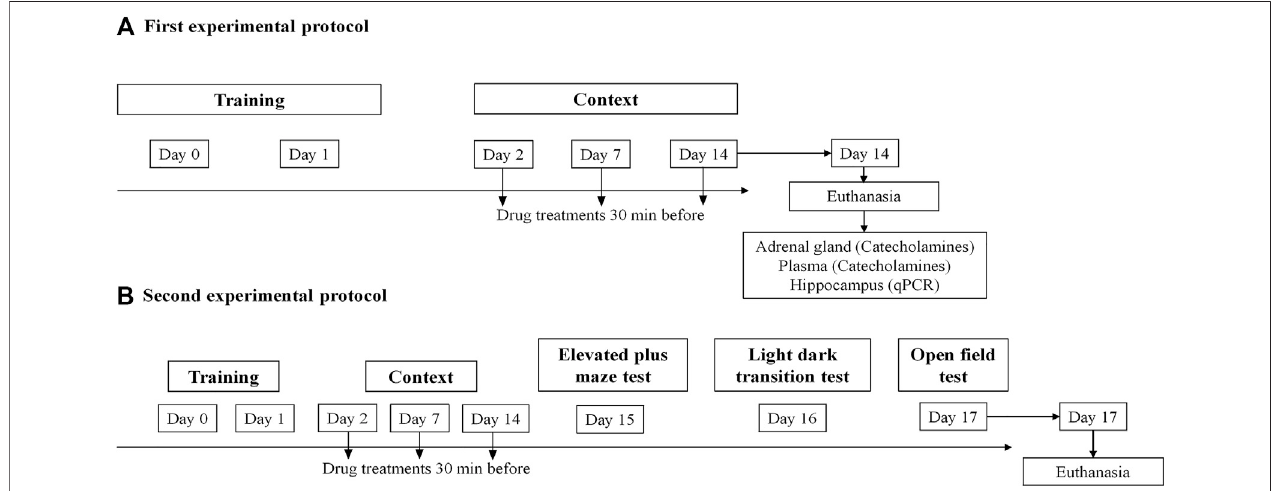
FIGURE1| Schematicrepresentationoftheexperimentaldesign:treatments,behavioralprotocols,andsamplescollection. (A) Firstexperimentalprotocoland (B) second experimental protocol.